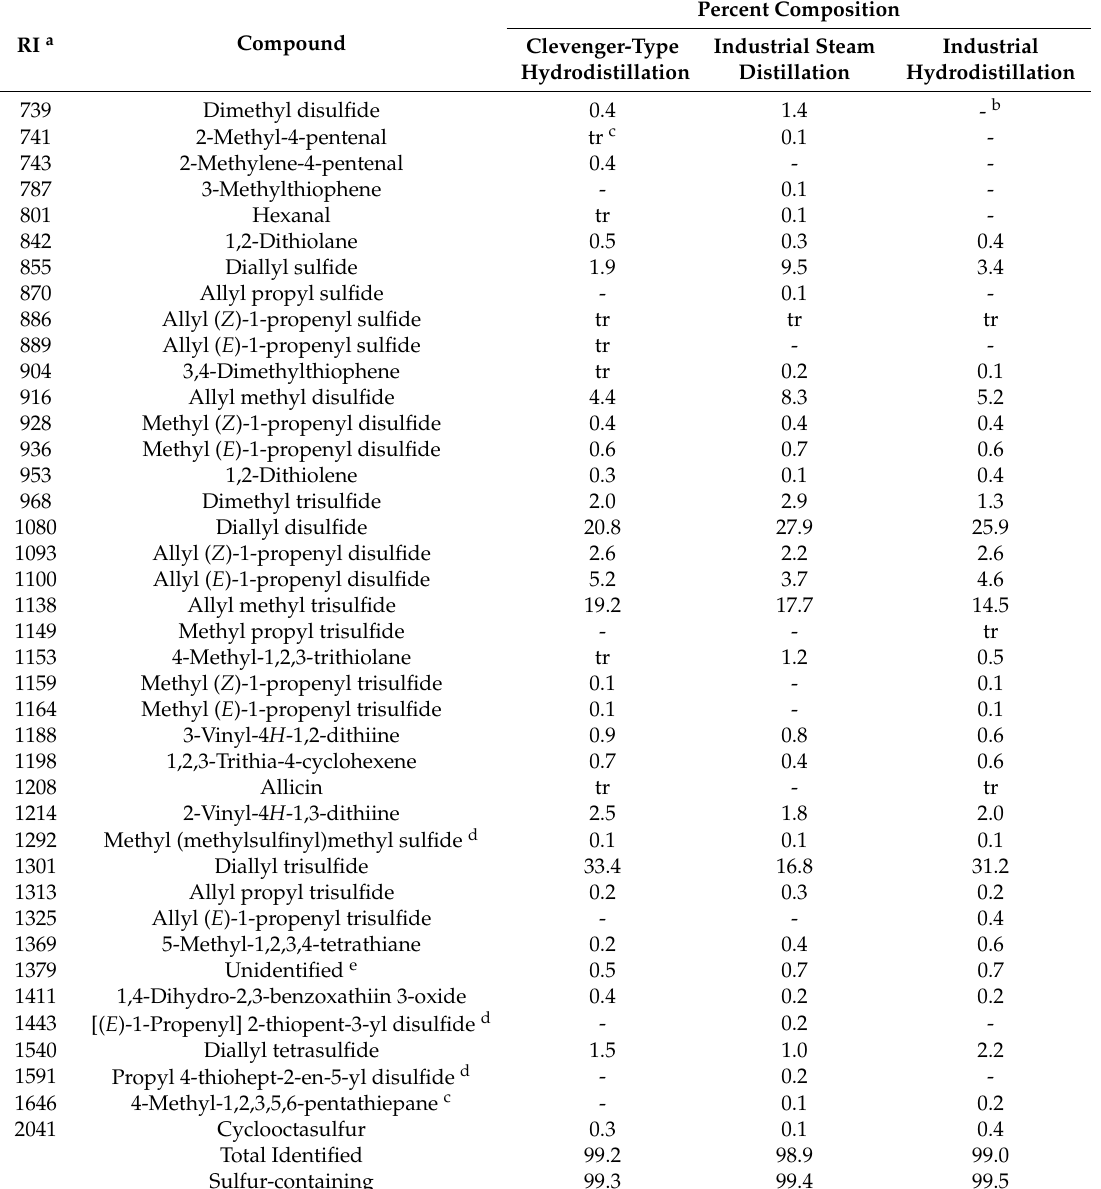
Table 2. Essential oil compositions of garlic ( Allium sativum ) obtained by different distillation